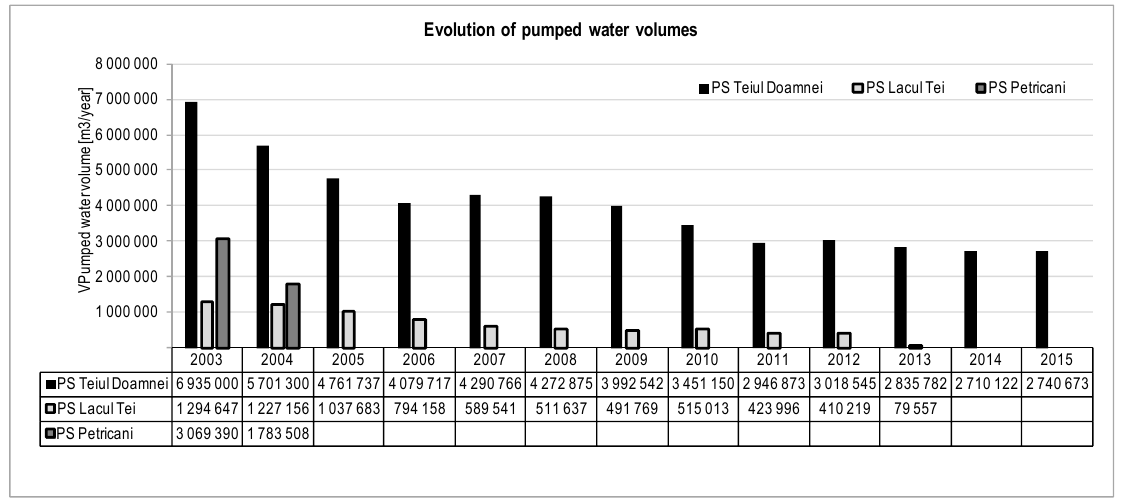
Figure 6. Evolution of pumped water volume for the booster stations in Tei-Colentina district.